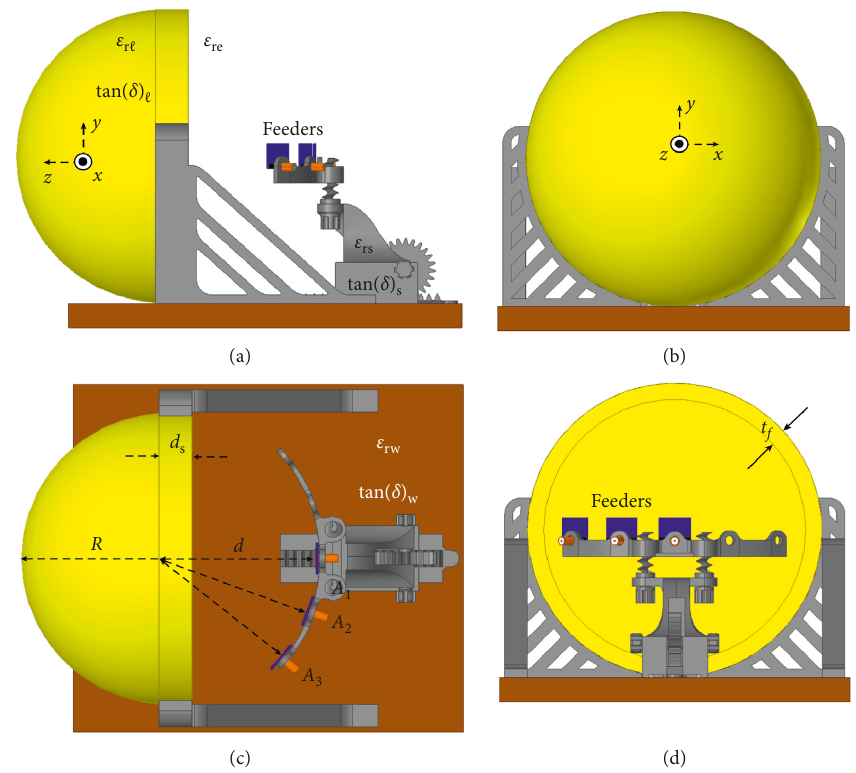
Figure 7: Model of the ultra-wideband dielectric lens antenna for beamsteering systems. (a) Side view. (b) Front view. (c) Upper view. (d) Back